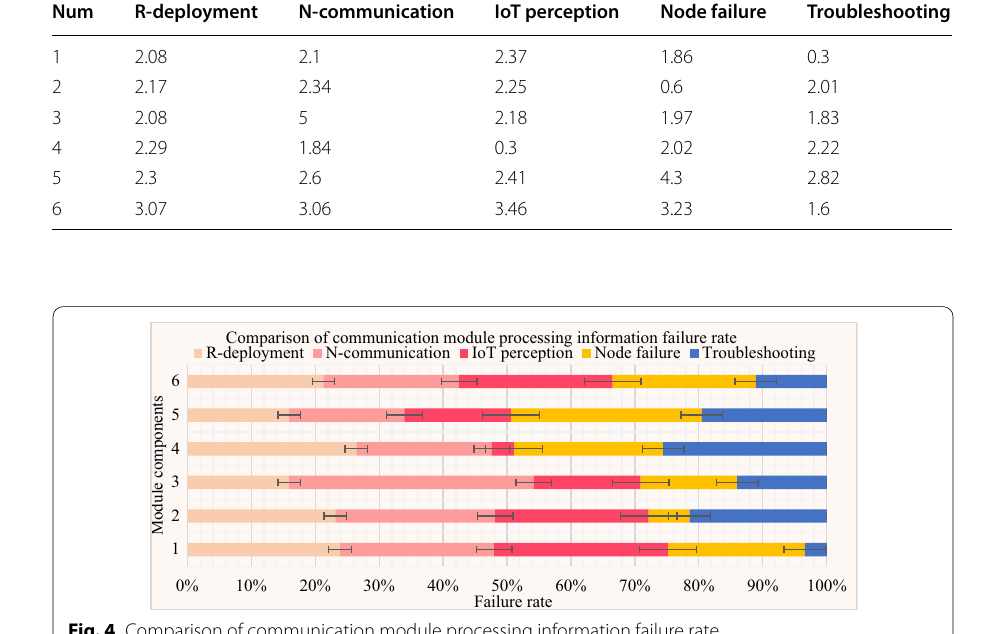
Table 3 The IoT system diagnoses the sample Num